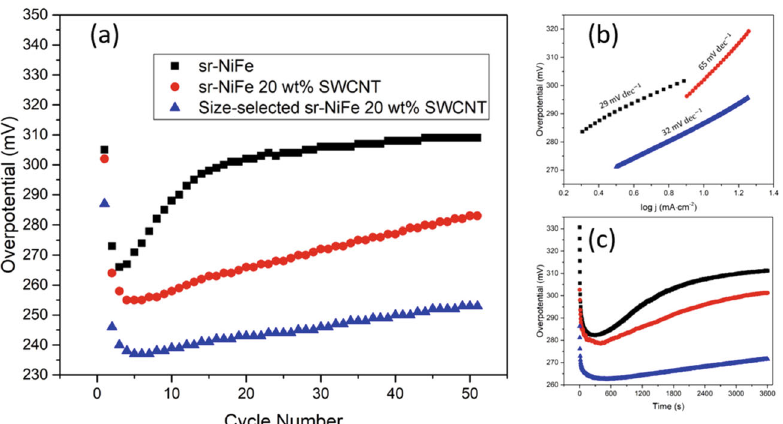
Fig. 5 Performance summary for ‘ fully optimized ’ catalysts in the scope of this work. Comparison of a overpotentials through 50 cycles and b Tafel slopes of OER electrodes prepared using size-selected sr-NiFe LDH with 20 wt% SWCNT, a nonsize-selected composite and pure sr-NiFe LDH. c Chronopotentiometry curve of the optimized electrode through 1 h at 10 mA.cm − 2